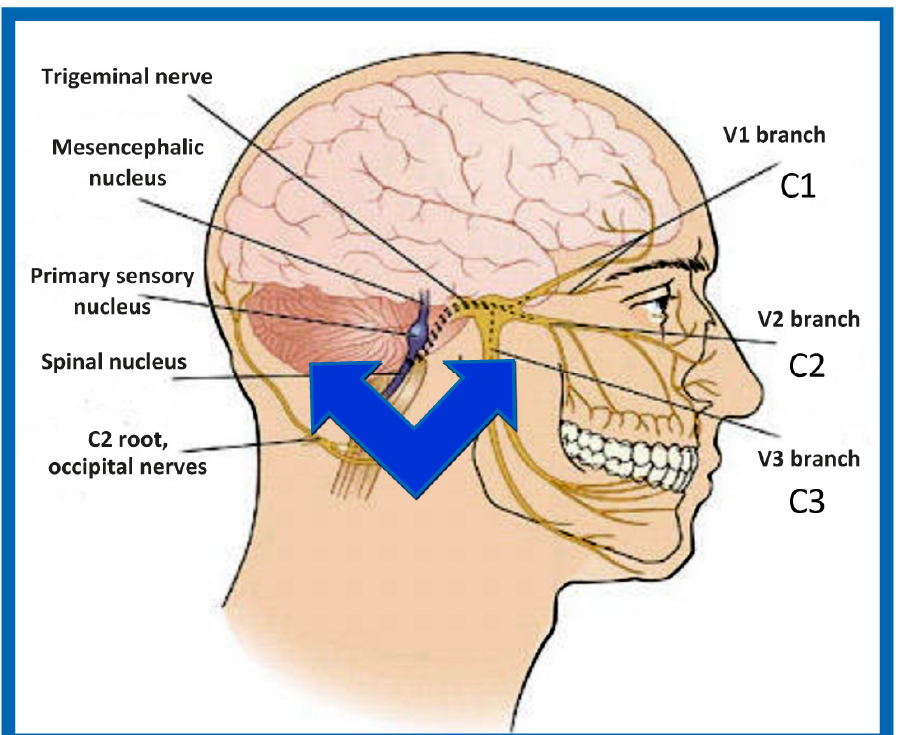
Figure 1. Trigeminocervical convergence. Source: Rocabado Institute, Chile. The convergence of cervical and trigeminal afferents on second-order neurons in the trigeminocervical nucleus may refer to pain from the upper cervical spine into the head and face. Furthermore, bi-directional interactions between the trigeminal and upper cervical afferents may also explain the cervical symptoms of trigeminal origin.